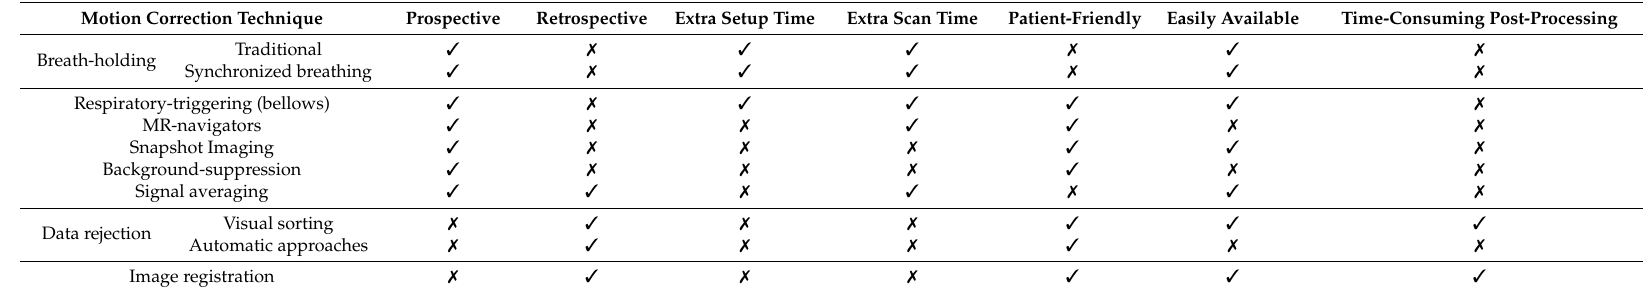
Table 5. Motion correction strategies most relevant for renal